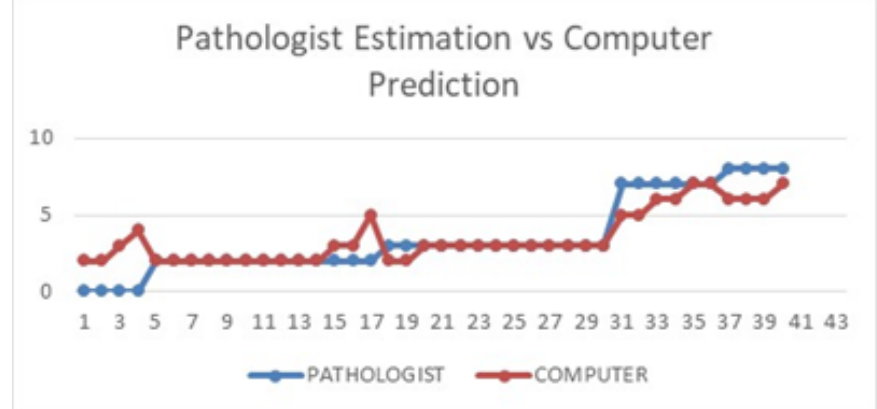
Figure 10. Pathologist’s estimation vs. computer prediction. Table 8. Allred scoring